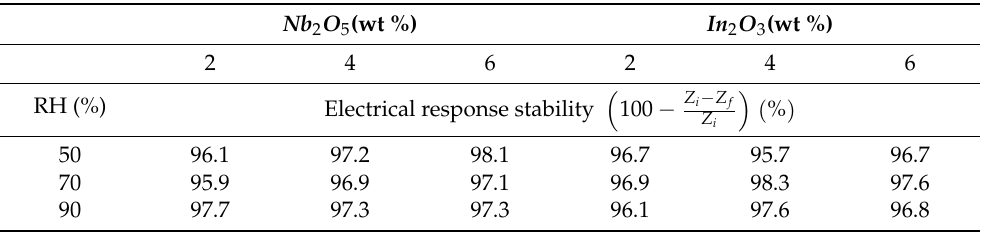
Table 2. Electrical response stability to moisture (at 50, 70 and 90% RH) for TW − Nb and TW − In sensors produced with 2, 4 and 6 wt % of Nb 2 O 5 and In 2 O 3 ,